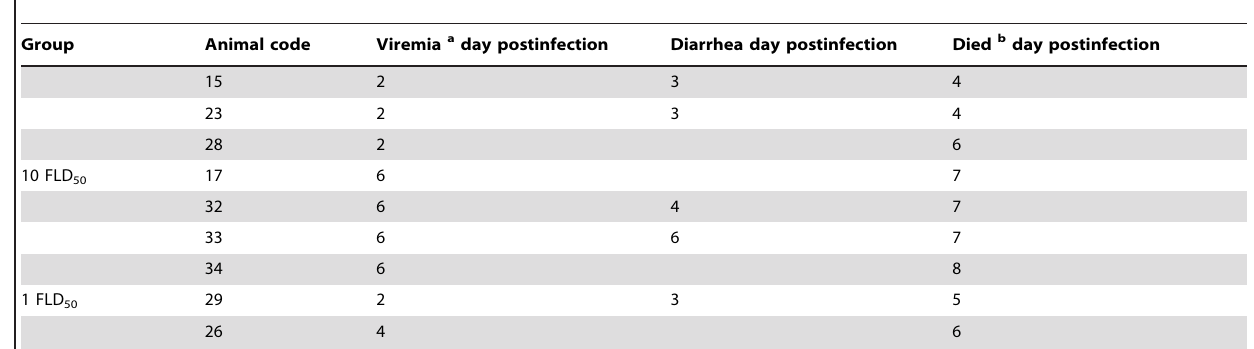
Table 3. Detection of viremia by TaqMan RT-PCR and cases of death of ferrets infected with H5N1 virus, A/VN/1203/04.